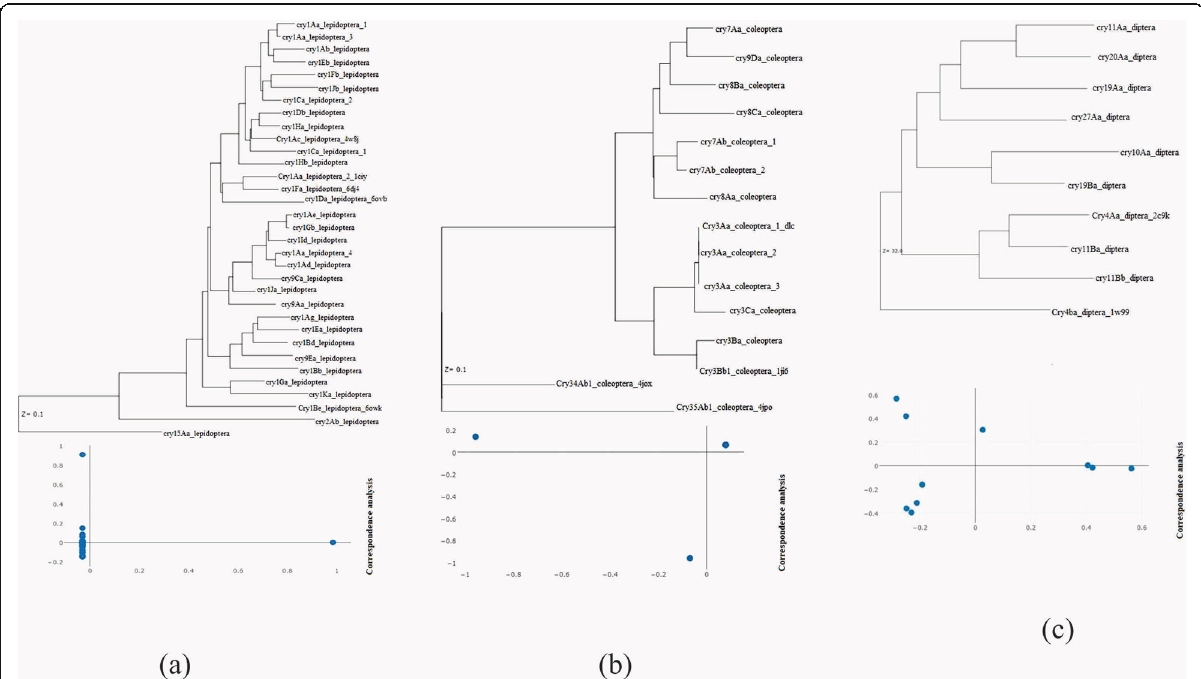
Fig. 7 a 3D Structure alignment result using Phyre 2 server of Cry proteins (Coleoptera). b 3D Structure alignment result using Phyre 2 server of Cry Proteins (Diptera). c 3D Structure alignment result using Phyre 2 server of Cry Proteins